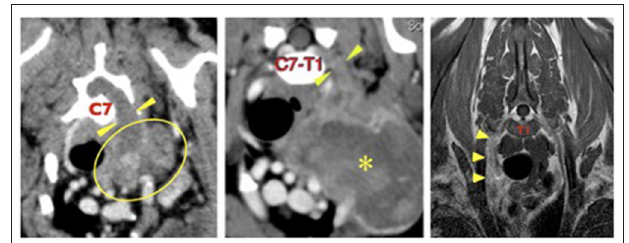
FIGURE 1 | Left, case 1: transverse CT image at the level of the C7 vertebral body. There is a large, irregular soft tissue attenuating mass in the left axilla (outlined) which extends dorsally (arrowheads) through the enlarged C6–C7 intervertebral foramen to enter the vertebral canal. Middle, case 2: transverse CT image at the level of the C7–T1 intervertebral formamina showing a large, irregular mass (asterisk in its center) in the left axilla, extending proximally (arrowheads) through the C7–T1 intervertebral foramina to enter the vertebral canal. Right, case 3: transverse T1 weighted post-contrast image at the level of the mid T1 vertebral body. The right C8 spinal nerve (arrowheads) is enlarged and irregular and shows mild, homogenous contrast uptake. The right side of the dog is on the left side of each